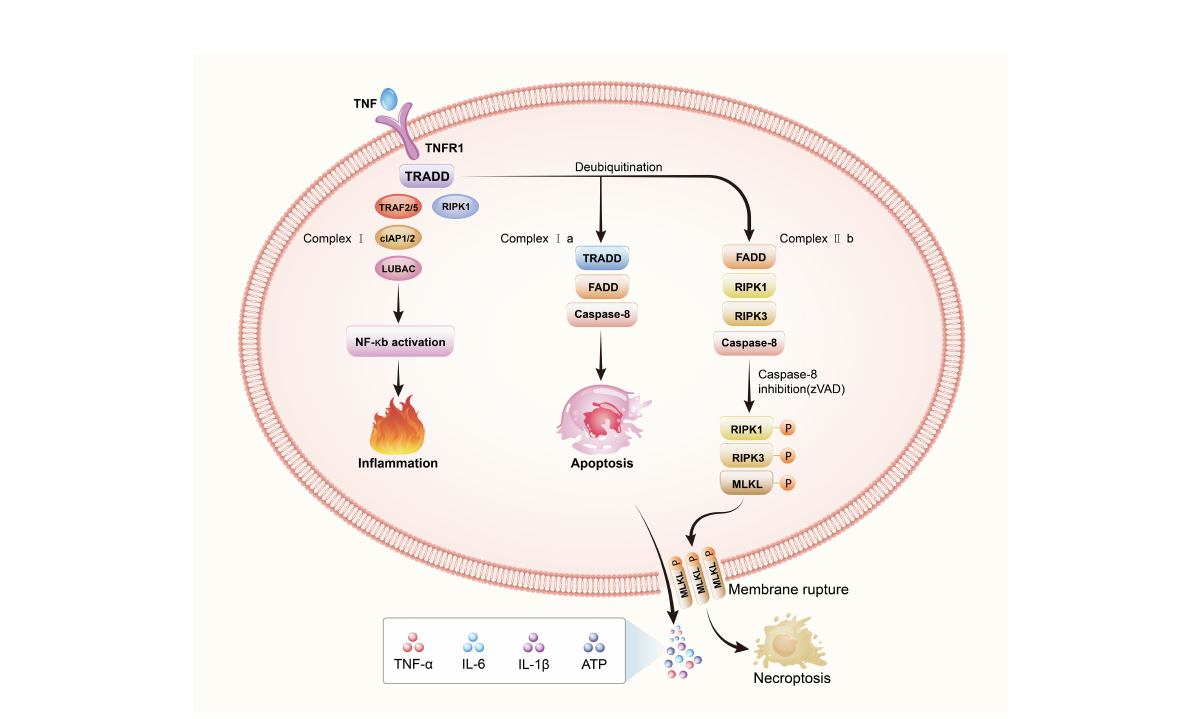
FIGURE 2 Necroptosis: a regulatory cell death. The death receptor signaling pathway is responsible for necroptosis This image depicts the interaction between tumor necrosis factor (TNF) and TNF receptor 1(TNFR1). When the binding of tumor necrosis factor- a (TNF a ) to TNF receptor 1 (TNFR1), TNFR1 ligation triggers the assembly of complex I composed of TRADD, RIPK1, TRAF2/5, cIAP1/2 and LUBAC. Cell survival, apoptosis, and necroptosis are all possible consequences of complex I formation, which are regulated by different downstream cytosolic signaling complexes. Cell survival is boosted by ubiquitination of RIPK1, which activates the NF- k B pathway and promotes cell proliferation. Under a certain circumstance, deubiquitination of RIPK1 can result in the complex recruiting TRADD, FADD and caspase-8 forming complex IIa which activates apoptosis, or recruiting FADD, RIPK3, and caspase-8 forming complex IIb, which activates necroptosis. By blocking caspase-8, the binding of activated RIPK1 and RIPK3 leads to RIPK3 activation, which then phosphorylates and activates a pseudokinase called MLKL. MLKL undergoes oligomerization and translocates to and permeabilizes the plasma membrane to induce